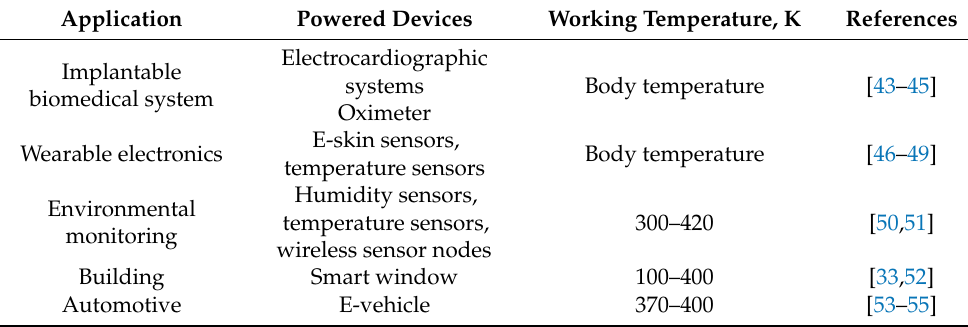
Table 2. Potential applications of low-operating-temperature TEGs.